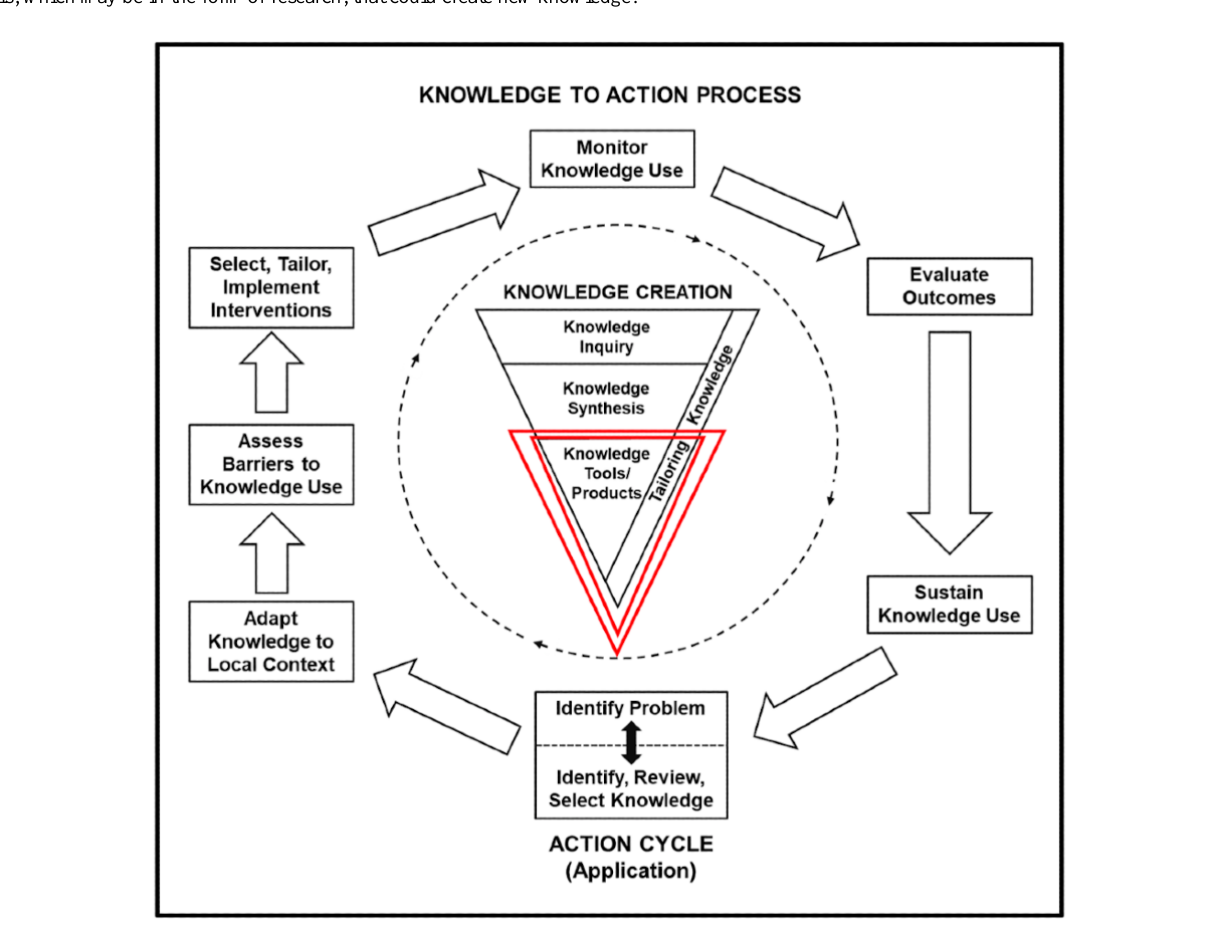
Figure 5. Graham's knowledge translation process (Straus et al, 2011). The central idea of this process is to create knowledge through diverse knowledge tools, which may be in the form of research, that could create new knowledge.